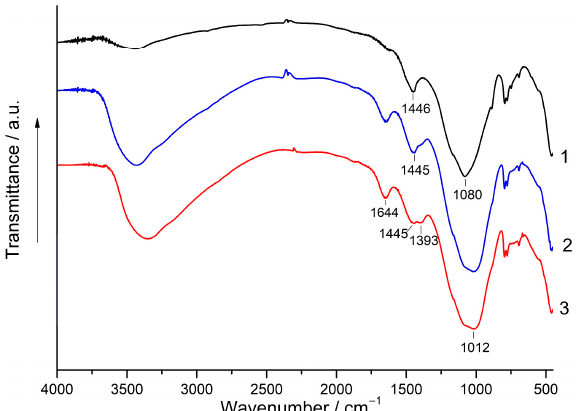
Figure 15. The FT-IR spectra: 1—the (99% FA + 1% magnesite) blend milled for 180 s; 2 and 3—the geopolymer synthesized using this blend after 7 and 28 d of curing, respectively.